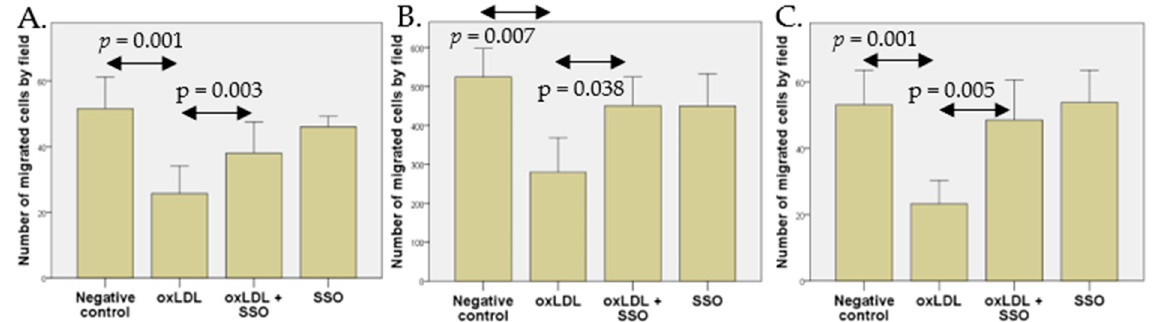
Figure 5. Migration of 93VU-147T, UM-SCC47, and UPCI-SCC154 cell lines exposed to oxLDL (30 µg/mL, 48 h). ( A ) Number of migrated 93VU-147T ( t -test, p = 0.001); ( B ) UM-SCC47 ( t -test, p = 0.007); and ( C ) UPCI-SCC154 ( t -test, p = 0.001) cells by x10 magnification field under oxLDL and SSO con-